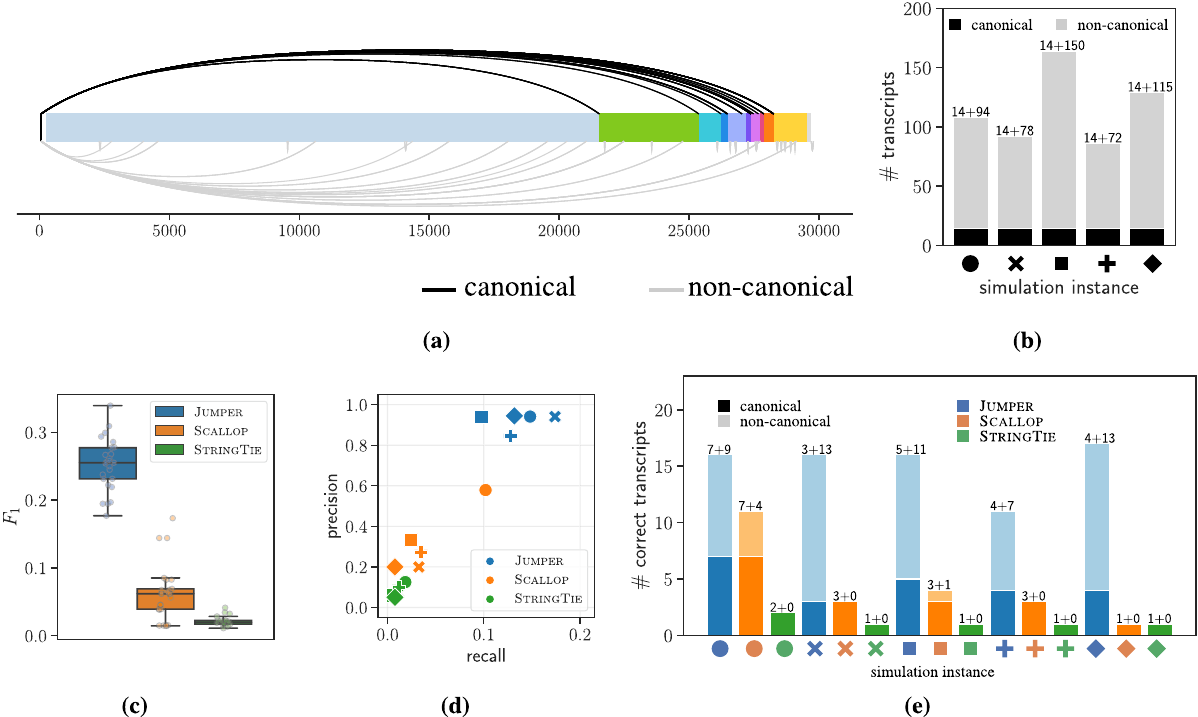
Fig. 3 JUMPER consistently outperforms SCALLOP 11 and STRINGTIE 12 in reconstruction of viral transcripts from simulated SARS-CoV-2 sequencing data. a Sashimi plot showing the canonical (black) and non-canonical (gray) discontinuous mappings supported by reads in short-read sample SRR11409417. b Number of canonical and non-canonical transcripts for fi ve simulation instances of ð T ; c Þ generated under the negative-sense discontinuous transcription model. c F 1 score of the three methods (JUMPER, SCALLOP, and STRINGTIE) for all the 5 × 5 = 25 simulated instances (i.e. fi ve technical replicates for each of the fi ve simulated transcriptomes) under the negative-sense discontinuous transcription model. Box plots show the median and the interquartile range (IQR), and the whiskers denote the lowest and highest values within 1.5 times the IQR from the fi rst and third quartiles, respectively. d Precision and recall values of the three methods with one of sequencing experiment for each simulated instance of ð T ; c Þ under the negative-sense discontinuous transcription model as input. e Total number of canonical and non-canonical transcripts recalled by the three methods for the simulated instances shown in panel ( d